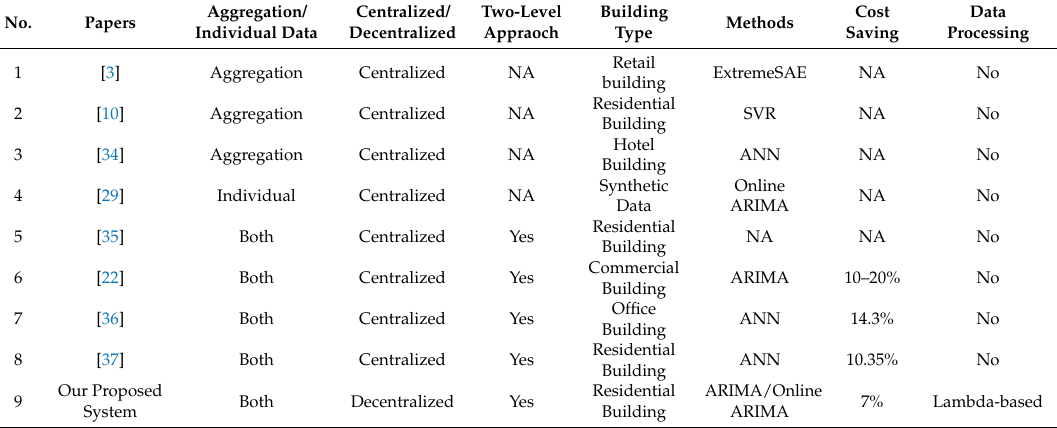
Table 3. Features of the proposed and recent